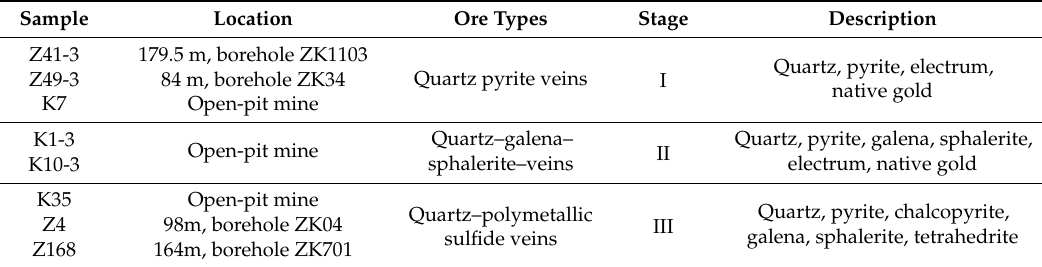
Table 1. Location and descriptions of samples from the Xiajinbao Au deposit.